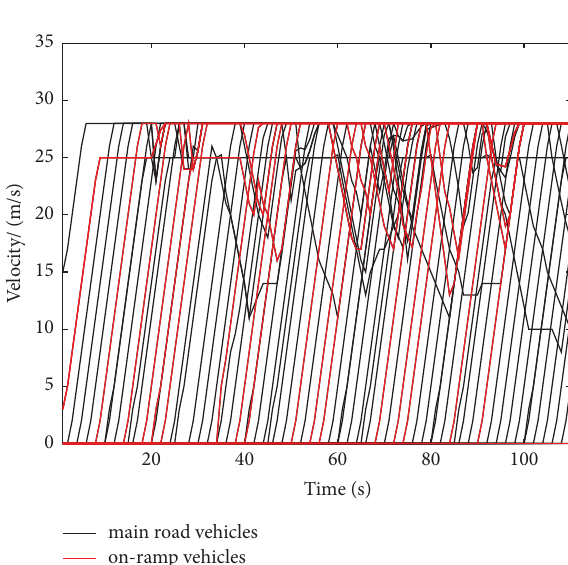
Figure 12: Infuence of main road input